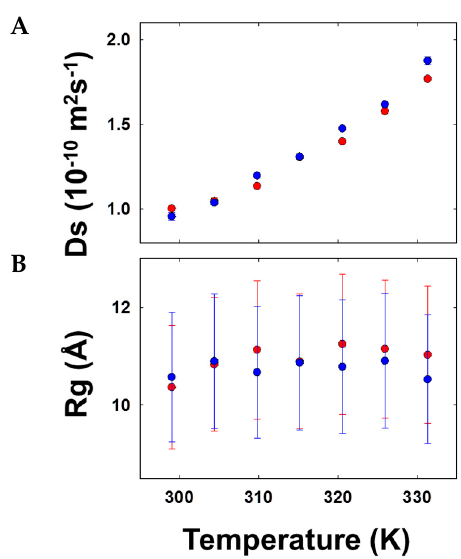
Figure 7. Molecular size estimation of AFGP8. ( A ) The plot of the translational di ff usion coe ffi cients of AFGP8-BS (red symbols) and AFGP8-TB (blue symbols) as a function of temperature. ( B ) Rg values of AFGP8-BS (red symbols) and AFGP8-TB (blue symbols) estimated by converting of the di ff usion coe ffi cient into the hydrodynamic radius.